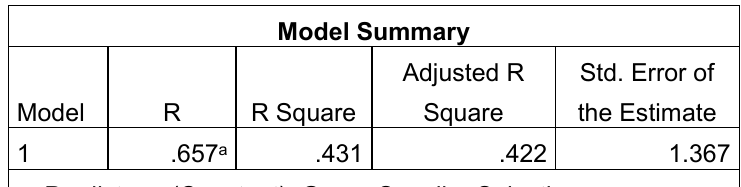
Table 2. Determination Coefficient Test Results